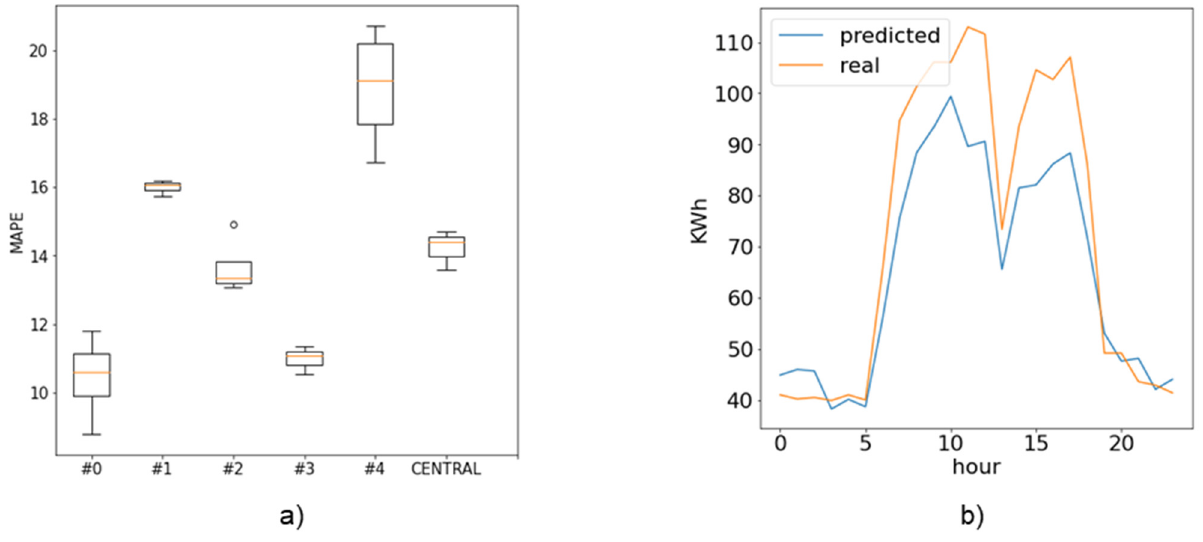
Figure 11. ( a ) Blockchain-based distributed FL model accuracy when trained with non-IID data; ( b ) Energy prediction result for Prosumer